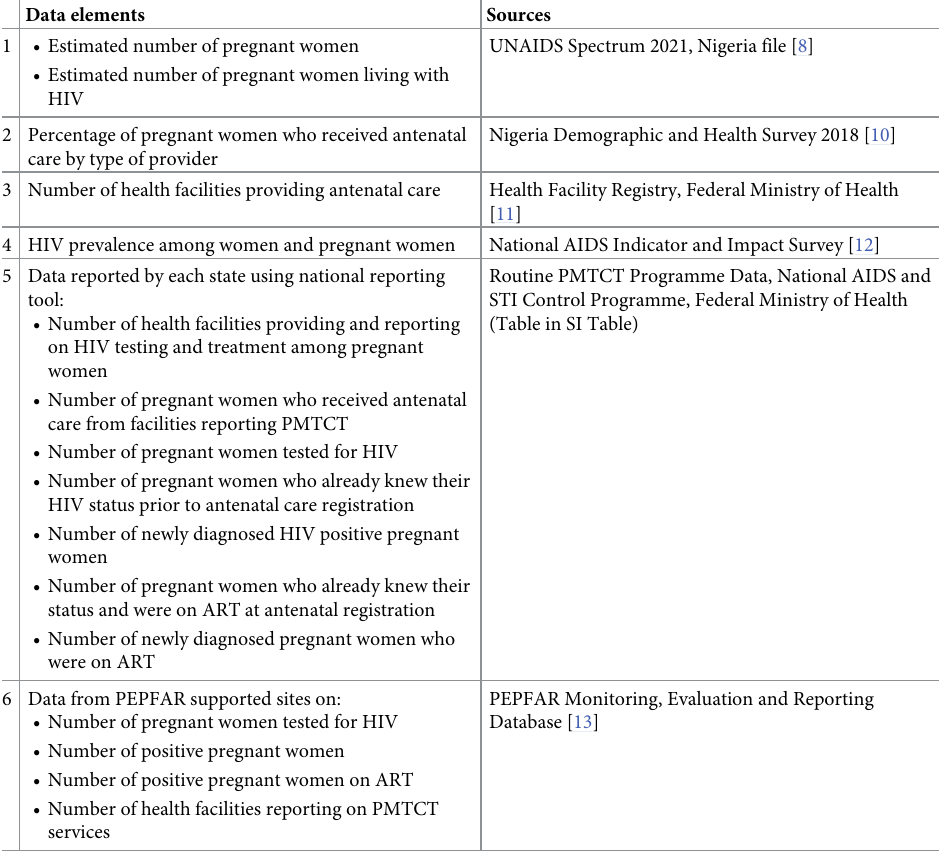
Table 1. Data used in analysis of ART coverage among pregnant women living with HIV and their sources. Data